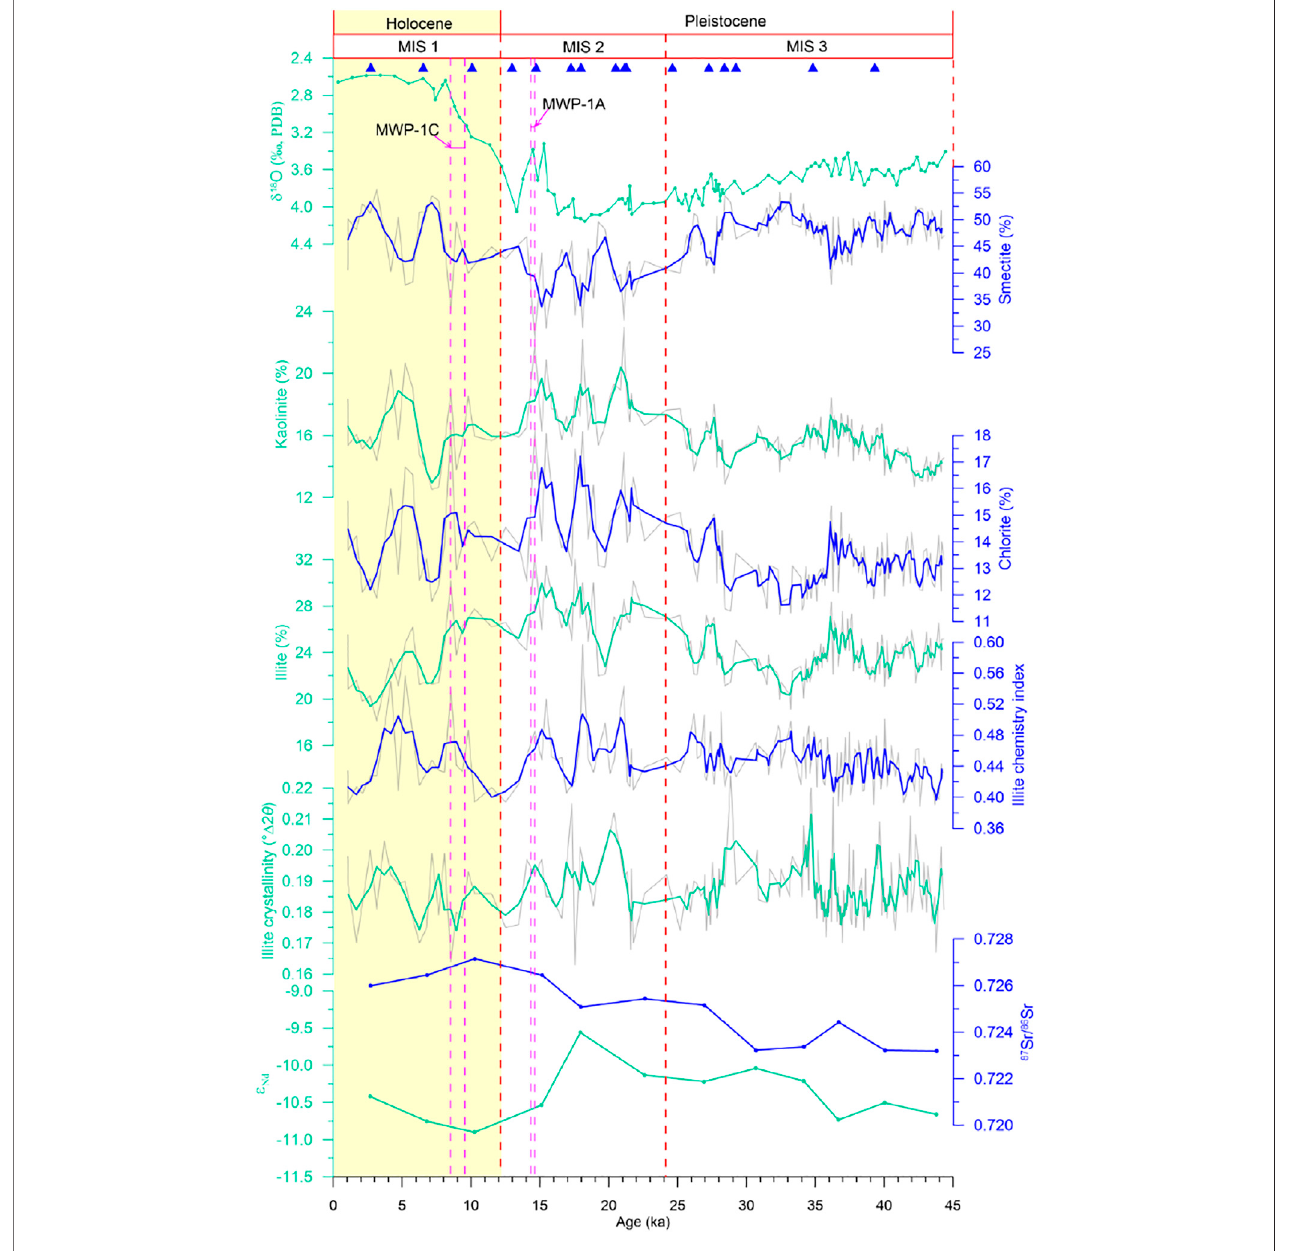
FIGURE 3 | Temporal variations of clay mineral assemblage and Sr-Nd isotopic values of Core MD05-2896 over the last 45 ka. The benthic foraminiferal C. wuellerstor fi δ 18 OstratigraphyandforaminiferalAMS 14 Cdatings(bluetriangle)(WanandJian,2014;Wanetal.,2020)arealsodisplayed.Dashedmagentalinesindicate the meltwater pulses 1A (MWP-1A) (Hanebuth et al., 2000) and 1C (MWP-1C) (Tjallingii et al., 2010). MIS 1 (0 – 12.05 ka), MIS 2 (12.05 – 24.11 ka), and MIS 3 (24.11 – 45.00 ka) display marine isotope stages (Martinson et al., 1987). The clay mineral data were smoothed by a three-point running average (coarse).